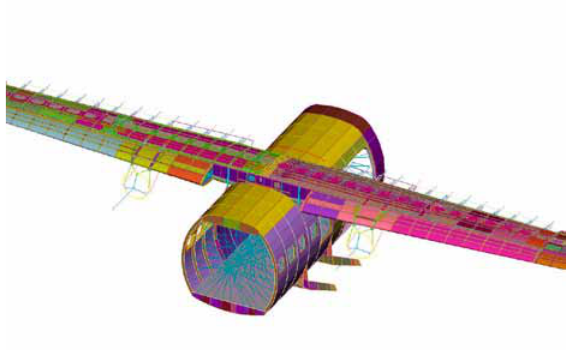
Fig. 3. The analyzed FE model of the wing structure